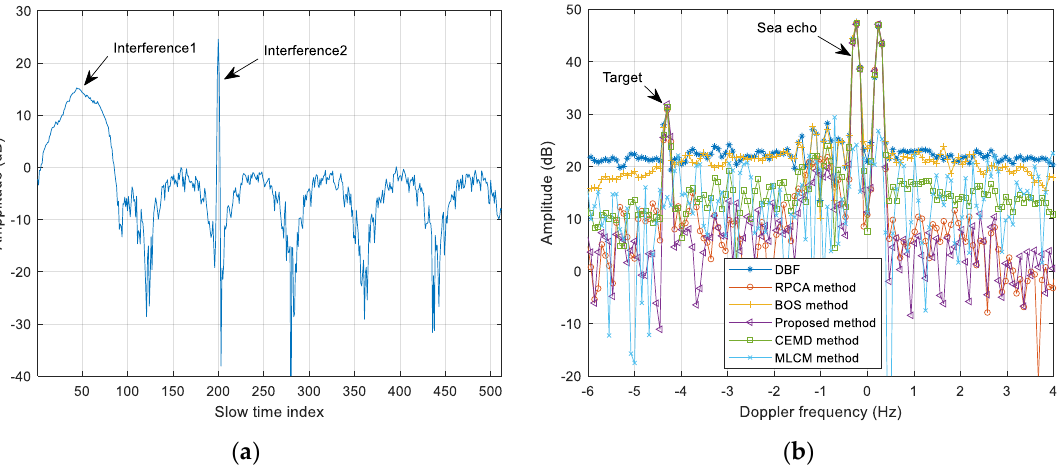
Figure 4. The results of the simulation data corrupted by two transient interferences: ( a ) Time − do- Figure main signal with transient interferences; ( b ) Doppler profile of the interference-removed result.